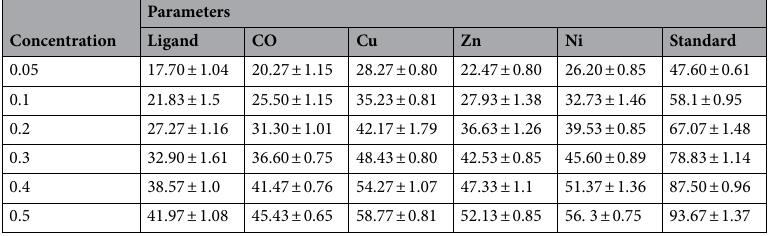
Table 7. The effect of ligand and its complexes cobalt (Co), copper (Cu), zinc (Zn) and nickel (Ni) on antioxidant AChE at different concentrations (0.05–0.5 mg/mL).